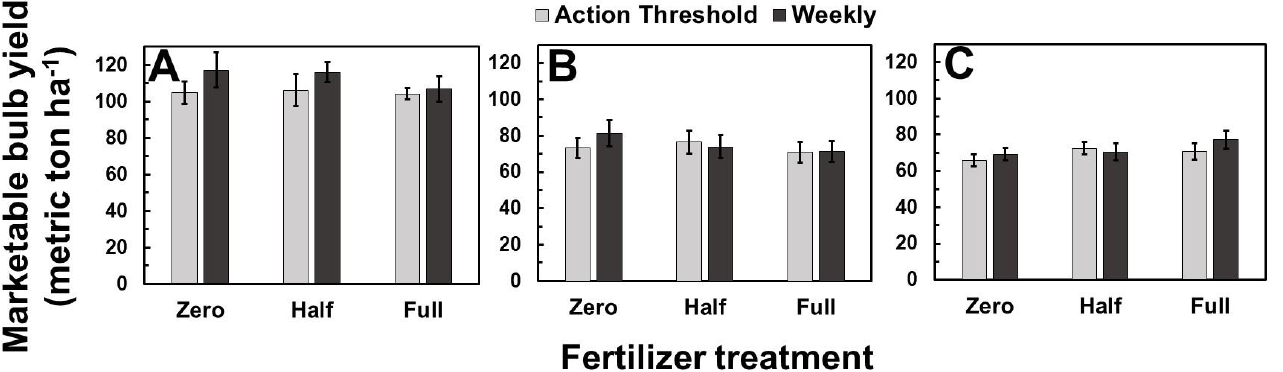
Figure 3. Mean ( ± SEM) marketable onion bulb yield for each fertilizer rate and insecticide program combination in 2019 ( A ), 2020 ( B ), and 2021 ( C ). There were no significant differences among treatments within each year (Tukey’s HSD, p > 0.05).